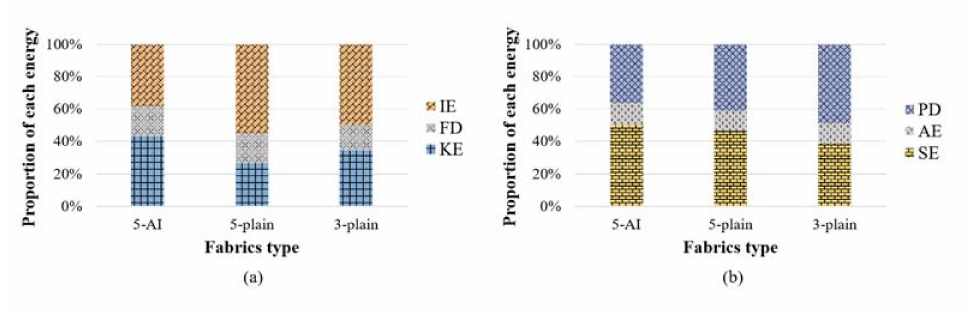
Figure 6. The contribution of each energy form in ( a ) the total energy and ( b ) the IE (total strain energy) of the fabric